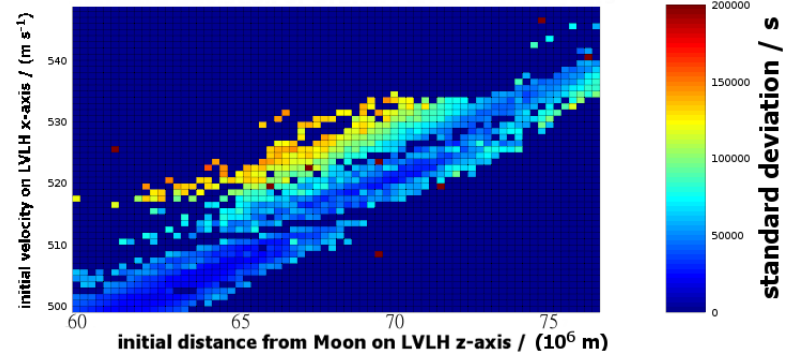
Figure 17. Replica of Figure 16 with higher resolution on the high-altitude region of interest.